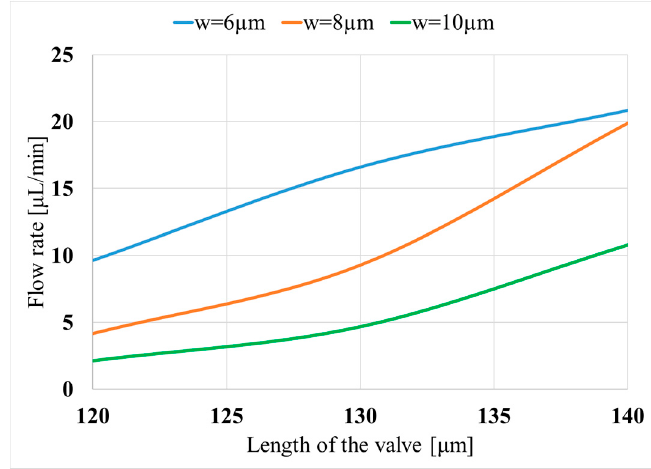
Figure 7. Variation of the obtained flow rate with the valve length ( h p ) for three valve widths (w); ( L p = 5mm, V = 400 V).